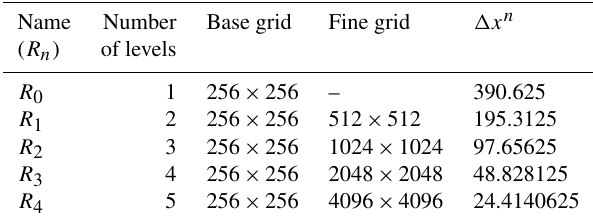
Table D1. Details of the five AMR runs R n